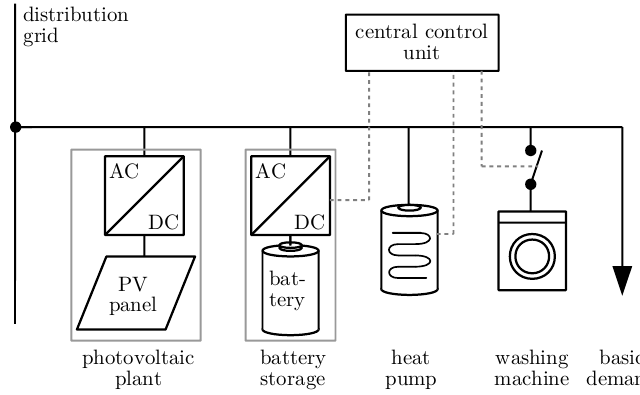
Figure 3. Scheme of the system setup on the demonstration site for real-world application of the smart energy management system. Measurement devices are not shown for clarity. Dashed lines symbolize communication of control